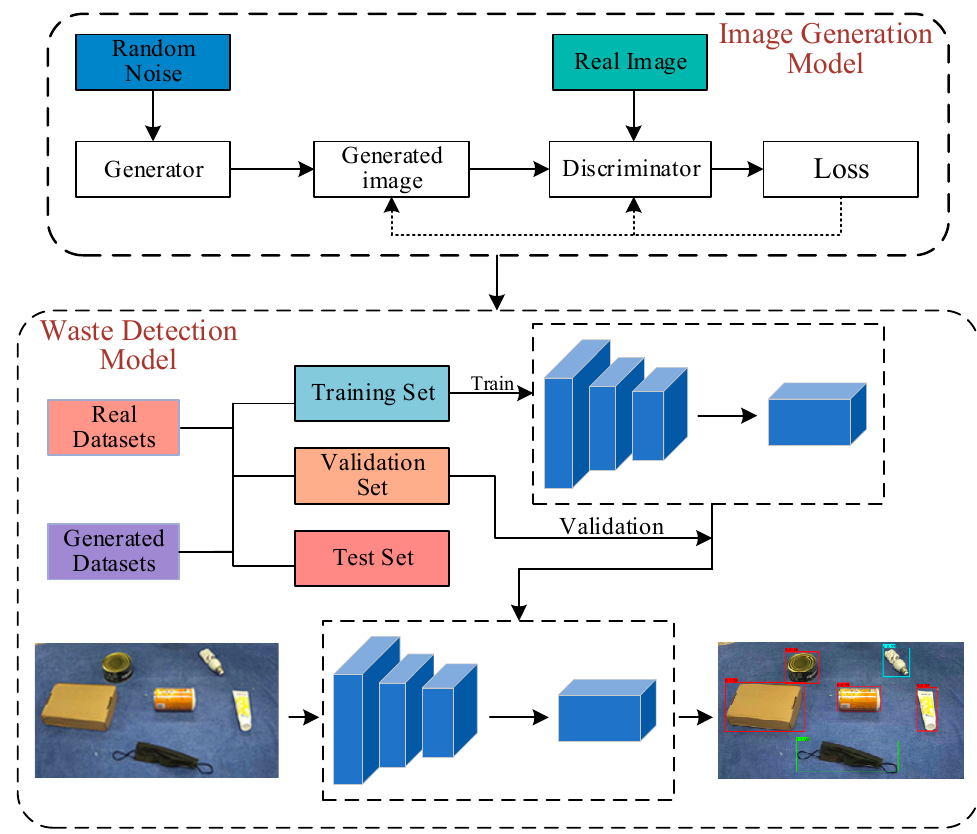
Figure 1. Data Augmentation + YOLO_EC System Flowchart.